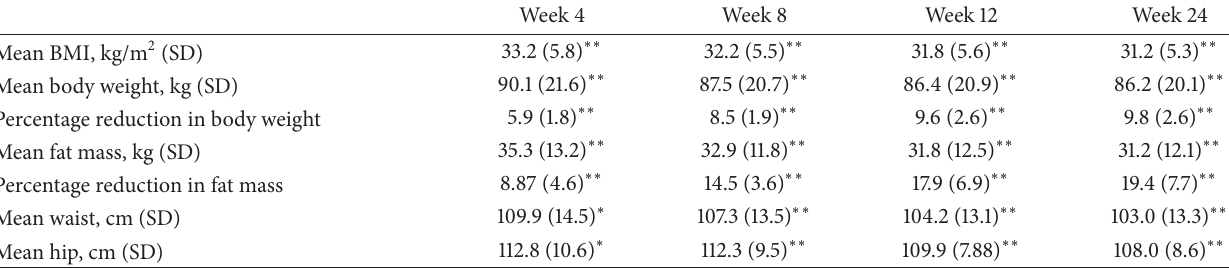
Table 2: Changes in weight, BMI, and body compositions at weeks 4, 8, 12, and 24.